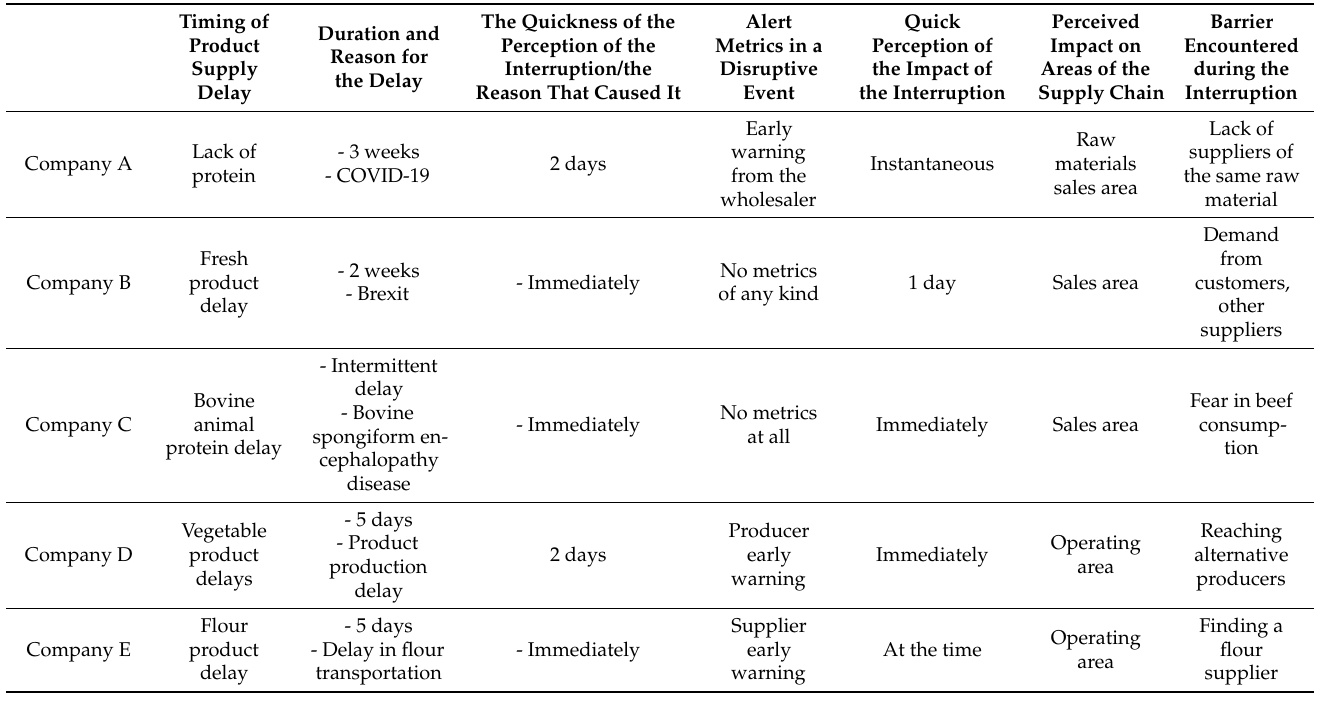
Table 3. Synthesis of results of supply chain